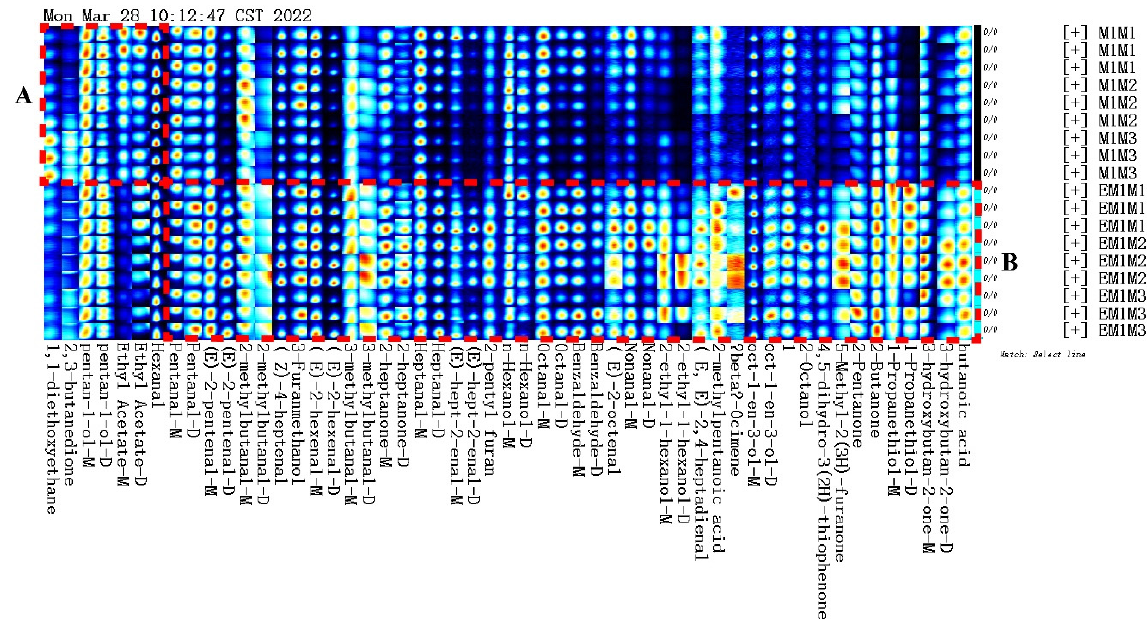
Figure 5. Gallery plot of selected volatile organic compounds in the gas-phase ion migration spectrum.